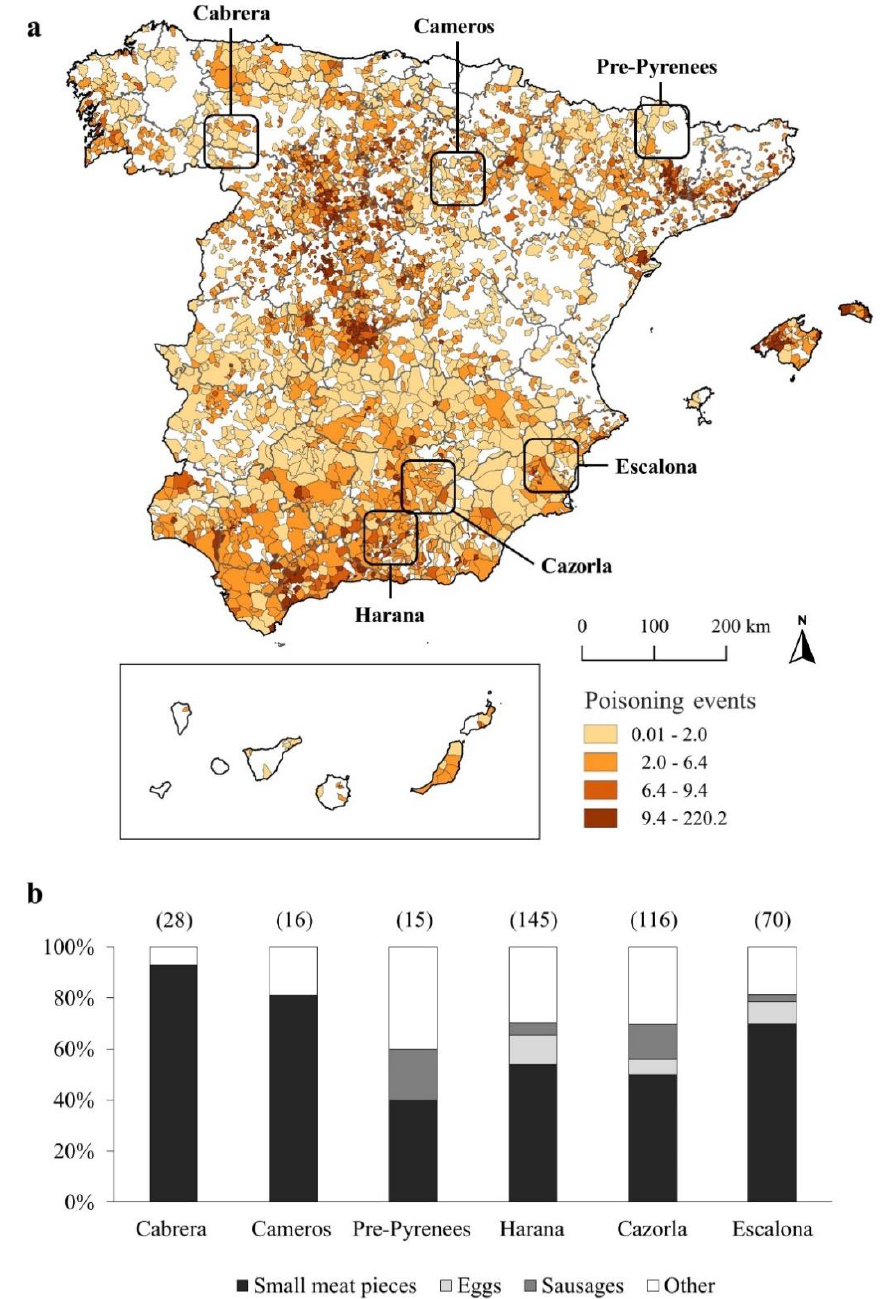
Figure 1. Poisoning events from the national database (“Antídoto Programme”) for the 1990–2015 period. ( a ) Distribution of poisoning events in Spain based on municipalities (no. of poisoning events per 100 km 2 of municipality surface) and location of the six study areas. Grey lines delimit the administrative provinces. Blank areas denote lack of data, which should not be interpreted as zero poison. ( b ) Bait types used to poison the fauna in the study areas, as recorded in the national poisoning database. Number of events are in brackets.